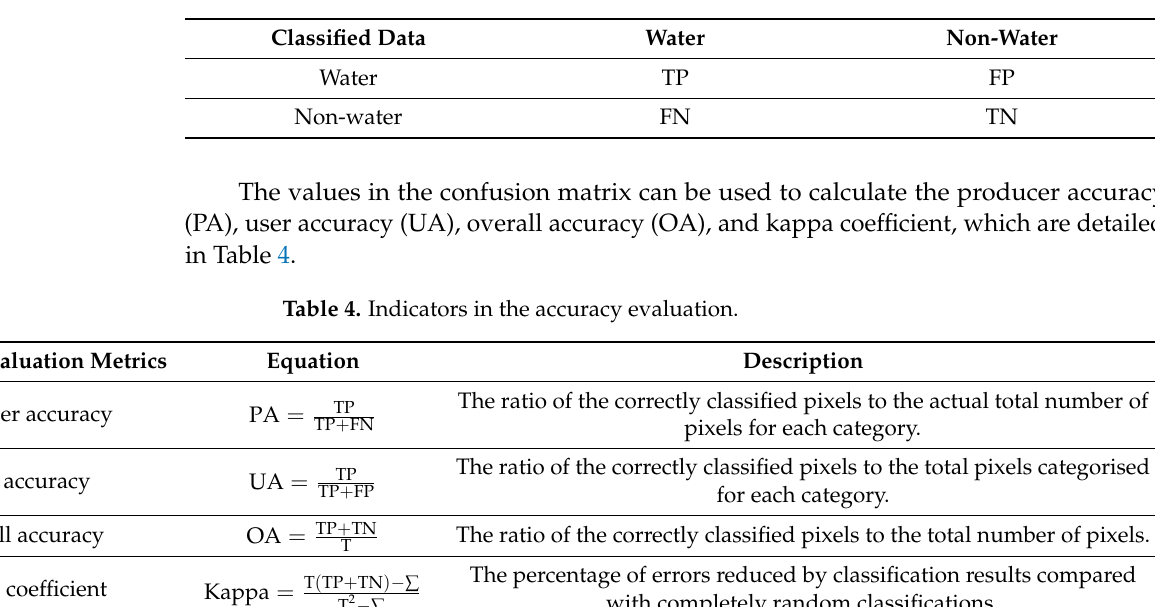
Table 3. Confusion matrix.